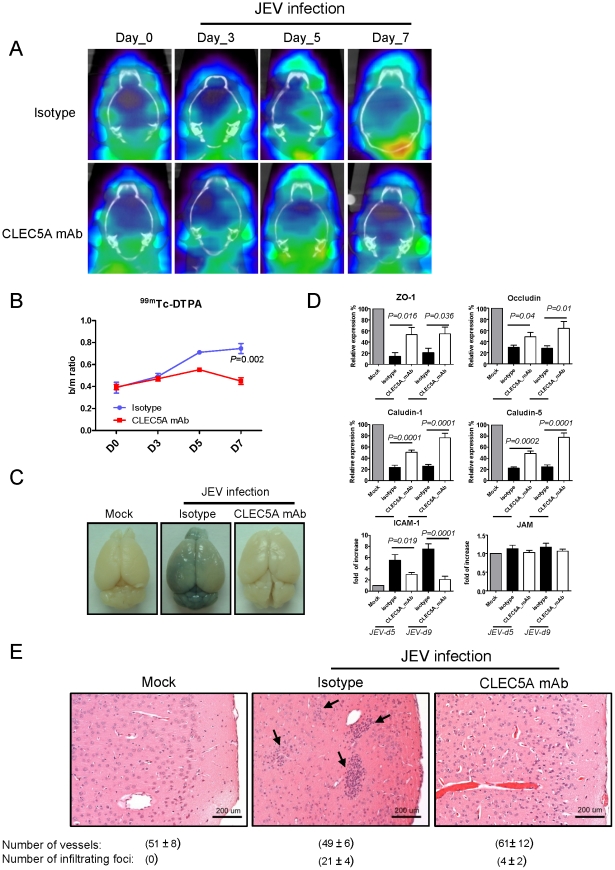
Effect of anti-CLEC5A mAb on dynamic changes in the BBB during JEV infection.(A) Stat1−/− mice were injected intravenously with 99mTc-DTPA to enable brain SPECT/CT imaging, before (D0) or after JEV challenge (100 pfu/mouse), in the presence of anti-CLECA5 mAb (3E3G4) or an isotype matched control. Antibody (150 µg/mouse) was administrated intraperitoneally on days 0, 2, 4, 6 and 8 to determine any protection effects in reduction to BBB permeability. Image datasets were reconstructed using the ordered-subset expectation maximization algorithm with standard-mode parameters. (B) The extent of BBB breakdown was calculated as the ratio of the mean counts/pixel in the region of the brain with the greatest accumulation of radiotracer divided by the mean counts/pixel in the neck muscle (b/m ratio). (C) Changes in BBB permeability at day 7 post JEV infection (100 pfu/mouse) were determined by Evans Blue assay. (D) Brains of JEV-infected mice (n = 5) with isotype control or anti-CLEC5A Ab treatment were harvested at day 5 and day 9 post infection to analyze the expression of transcripts encoding tight junction proteins and adhesion molecules by quantitative real-time PCR. For tight junction proteins, y-axis units represent the expression level of each target gene relative to mock control after internal control normalization; the expression level of adhesion molecules is displayed as fold increase relative to mock control. Two-tailed Student's t-tests were performed. (E) H&E staining of murine cerebral cortex at day 5 after JEV infection revealed the inhibitory effect of anti-CLEC5A mAb on perivascular cuffing. Scale bars, 200 µm. Five random fields of views in medium power field (original magnification (OM)×200) were photographed, and the numbers of foci and vessel cross sections in each sample were counted, summed up and represented as mean ± s.e.m. (under each picture) of four independent experiments.